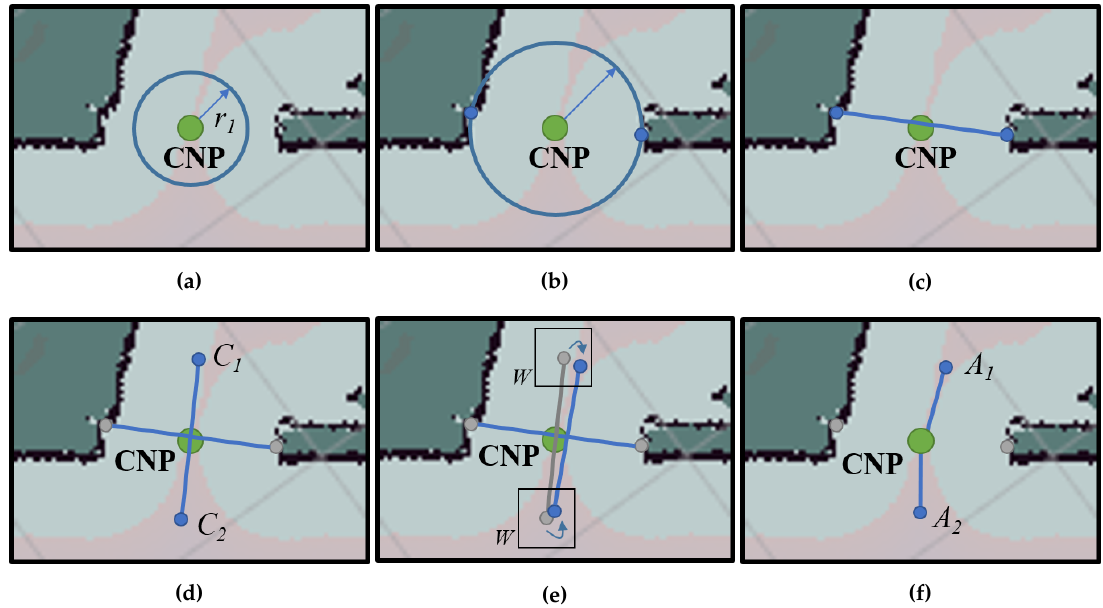
Figure 3. Generation of auxiliary navigation points (ANPs). ( a ) A growing circumference is created centered at the CNP until ( b ) two points of the cost-map touches it, ( c ) so that they are approximately aligned with the CNP. ( d ) A perpendicular line is generated and two candidates ( { C 1 , C 2 } ) for the ANPs are placed. ( e ) The positions of the candidate points are refined according to the cost-map, ( f ) yielding the final ANPs locations ( { A 1 , A 2 }